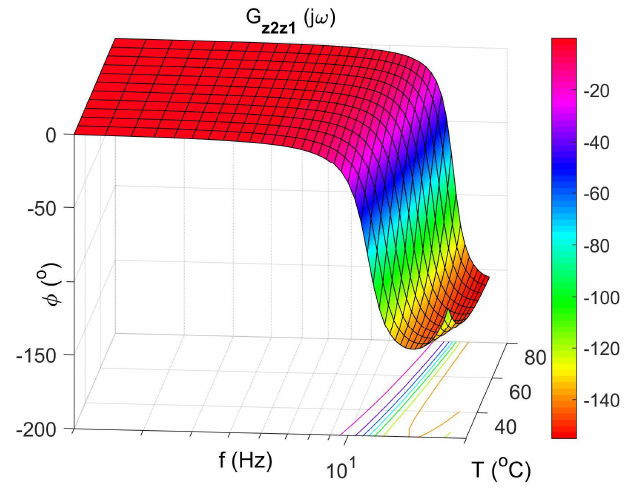
Figure 5. Absorber phase shift as a function of frequency and temperature, the transfer function G z 2 z 1 .